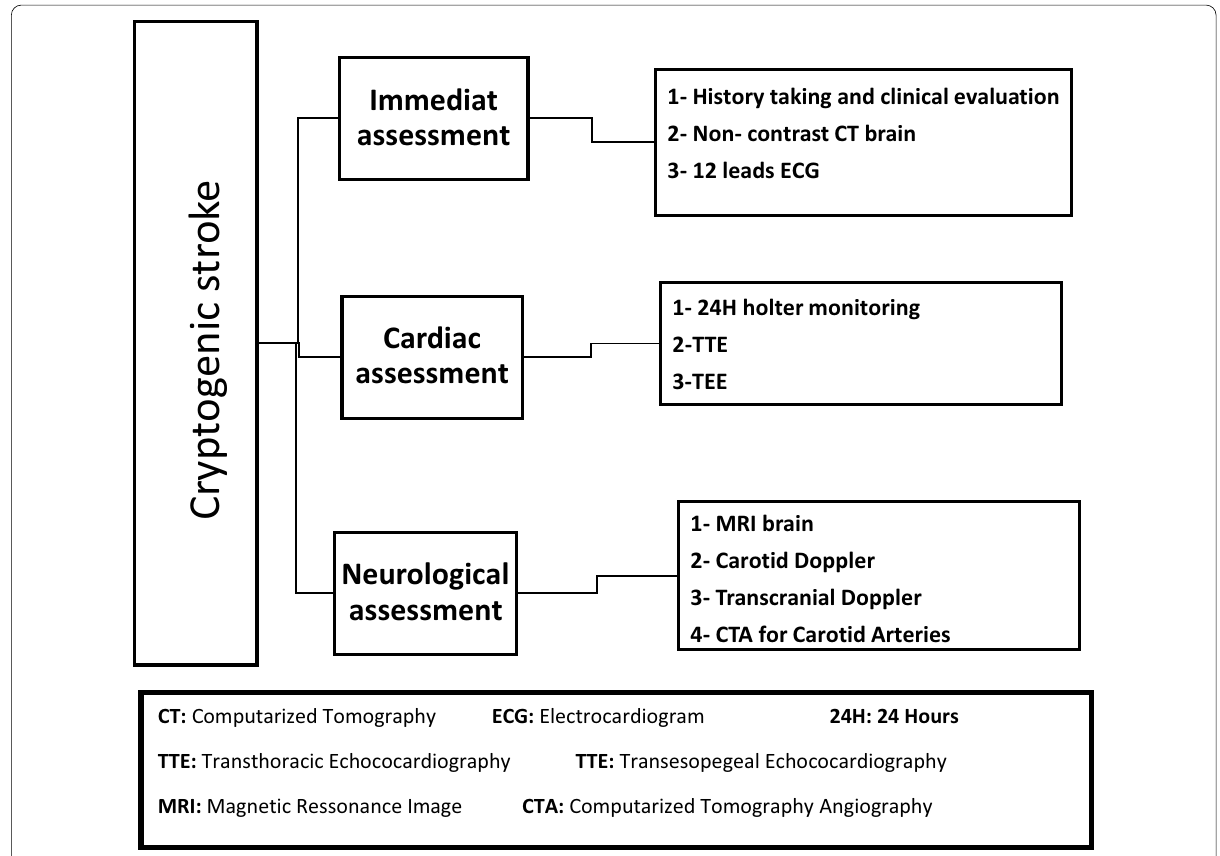
Fig. 1 Workup for patients with cryptogenic